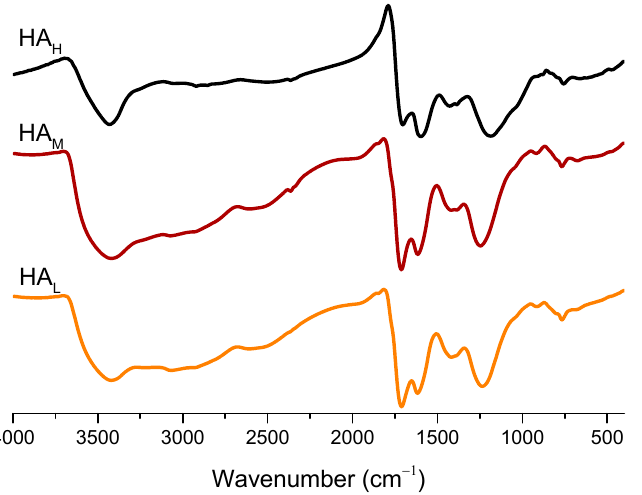
Figure 1. Fourier transform infrared (FTIR) spectra of HA fractions derived from weathered coal.